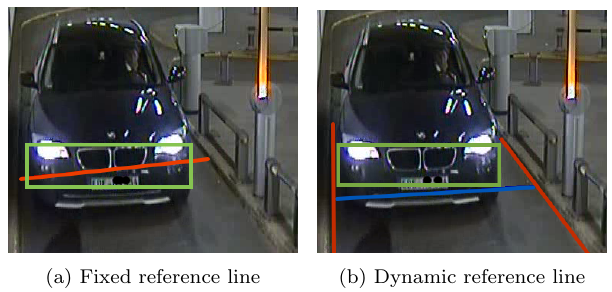
Figure 8: Comparison of the fixed and dynamic reference line. (Red) fixed reference lines, (Green) bounding box from the contour finding process , (Blue) dynamic reference line.